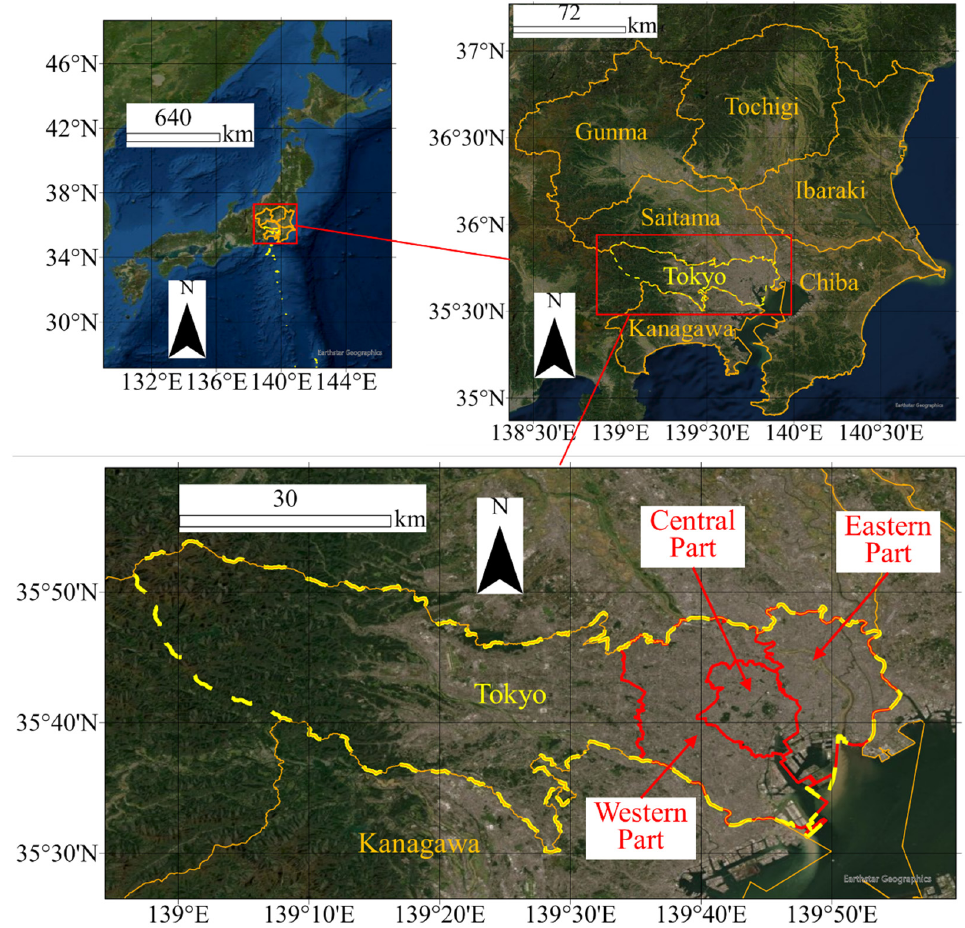
Figure 1. The location of the study area: the Tokyo Metropolitan Government area is indicated by a line of yellow dashes, while the eastern, central, and western parts of the city proper are indicated with red solid lines. In addition, prefectures surrounding Tokyo are indicated by orange solid lines. (Sources of satellite imagery: Esri, Maxar, Earthstar Geographics, and the GIS User Community).